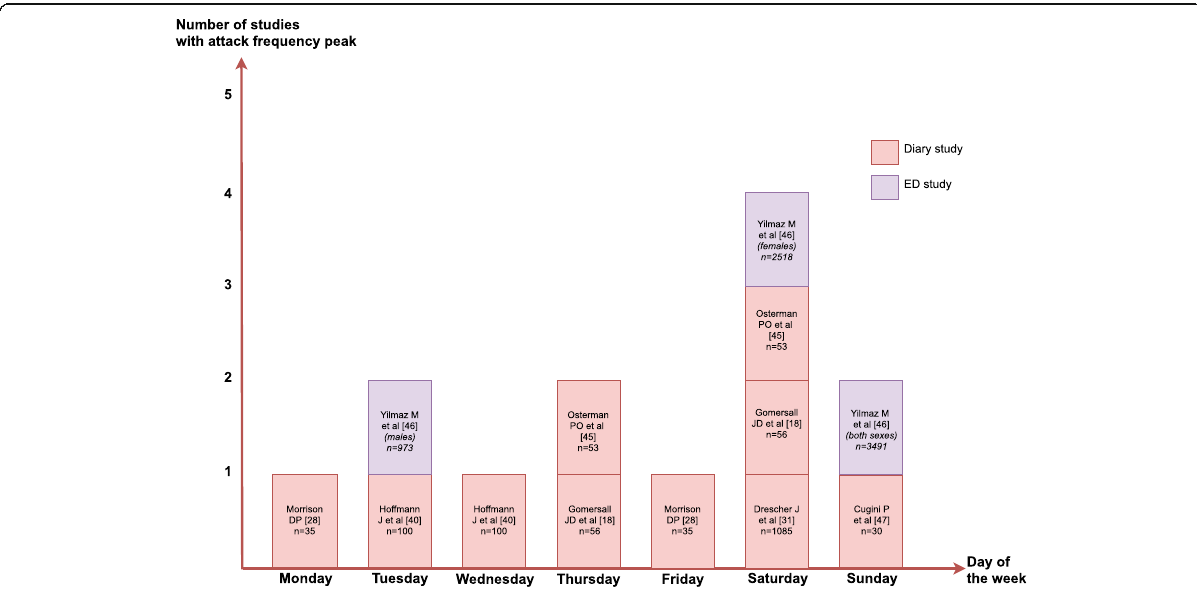
Fig. 3 Weekly distribution of migraine attacks. The number of studies reporting migraine attack frequency peak on each day of the week. Three studies found that attacks were equally distributed throughout the week [19, 25, 42]. One study found that there were fewer migraine attacks on Sundays compared to other days of the week [25]. n: total sample